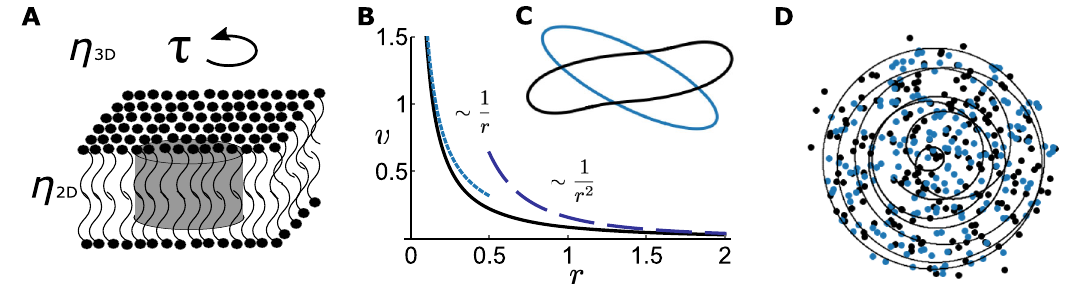
Fig. 2 Fluid fl ow and dynamics for membrane rotors. A A representation of a membrane rotor — a disk rotating due to a torque τ in the plane of the membrane. B The velocity fi eld due to a membrane rotor (solid line) which scales as a point vortex v ~ 1/ r at small distances (dotted), r / λ ≪ 1, transitioning to a QG behavior at large distances v ~ 1/ r 2 (dashed). C Contour dynamics of an ellipse with radii ratios r l / r s ≤ 3, where r l ( r s ) is the major (minor) axis. Starting from the same contour, the dynamics differ according to the radius relative to the SD length. Blue is in the limit r l ≪ λ . In this limit, the ellipse is rotating as a rigid body, as predicted by Kelvin 65 for an elliptic patch in an Euler fl uid. Black is in the limit r l ≫ λ , no longer conserving its shape since the large distance fl ow is in the quasigeostrophic regime. D 200 point membrane rotors, blue is the initial random con fi guration, black is the fi nal con fi guration. Solid line shows typical trajectory of an individual vortex. Note that the area did not change considerably since the system of vortices